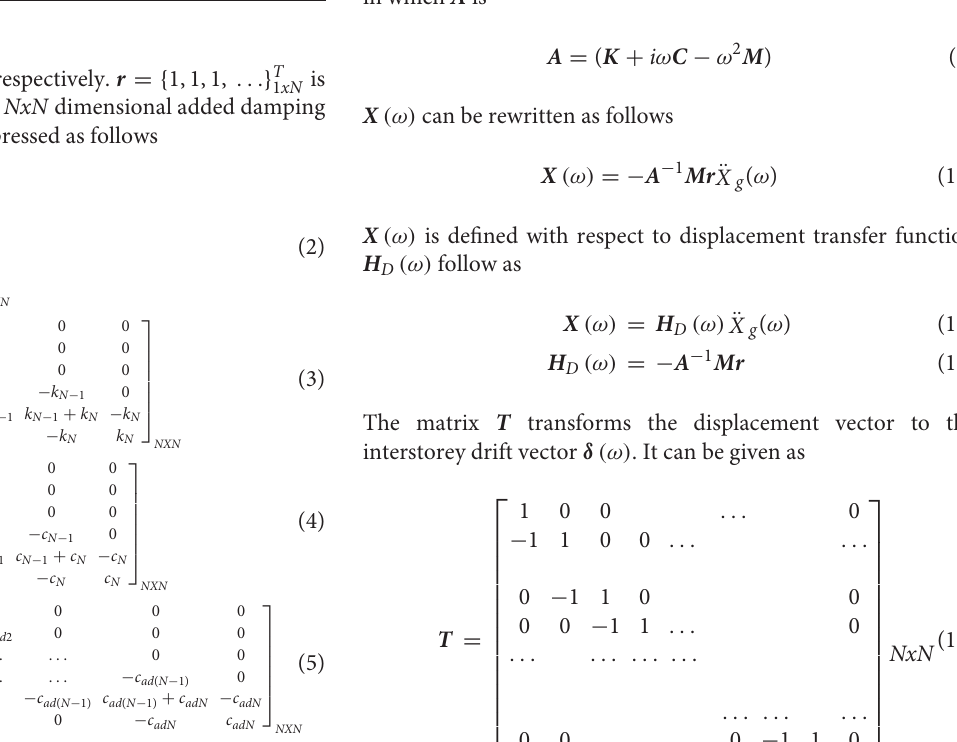
FIGURE 1 | Building model with added